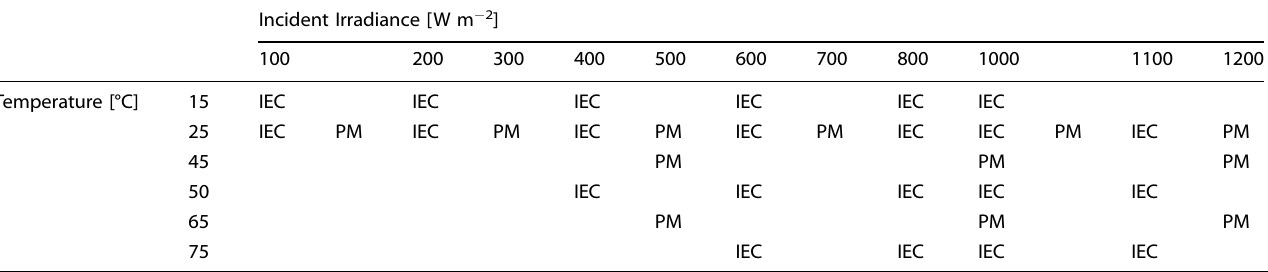
Table 3. IV curves required as per IEC 61853-1 (marked as IEC) and the IV curves required for using the proposed model (marked as